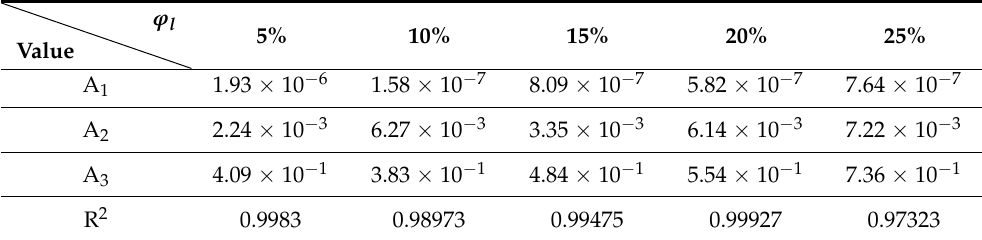
Table 1. η = A 1 B ˆ3 /2 + A 2 B ˆ1 /2 + A 3 fitting curve